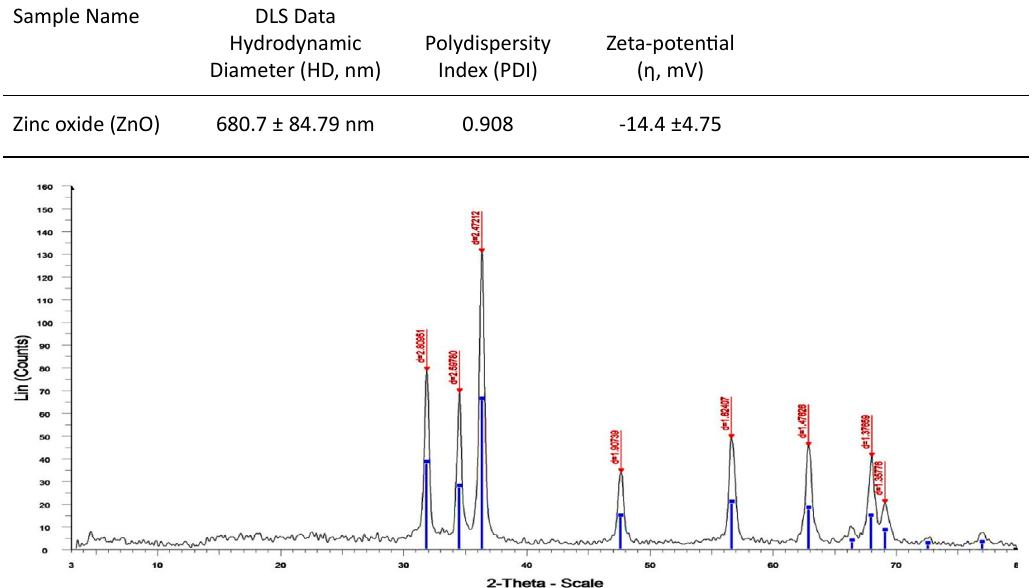
Fig. 6. XRD patterns of green synthesized ZnO-NPs using ( A. niger ) extracellular extract.